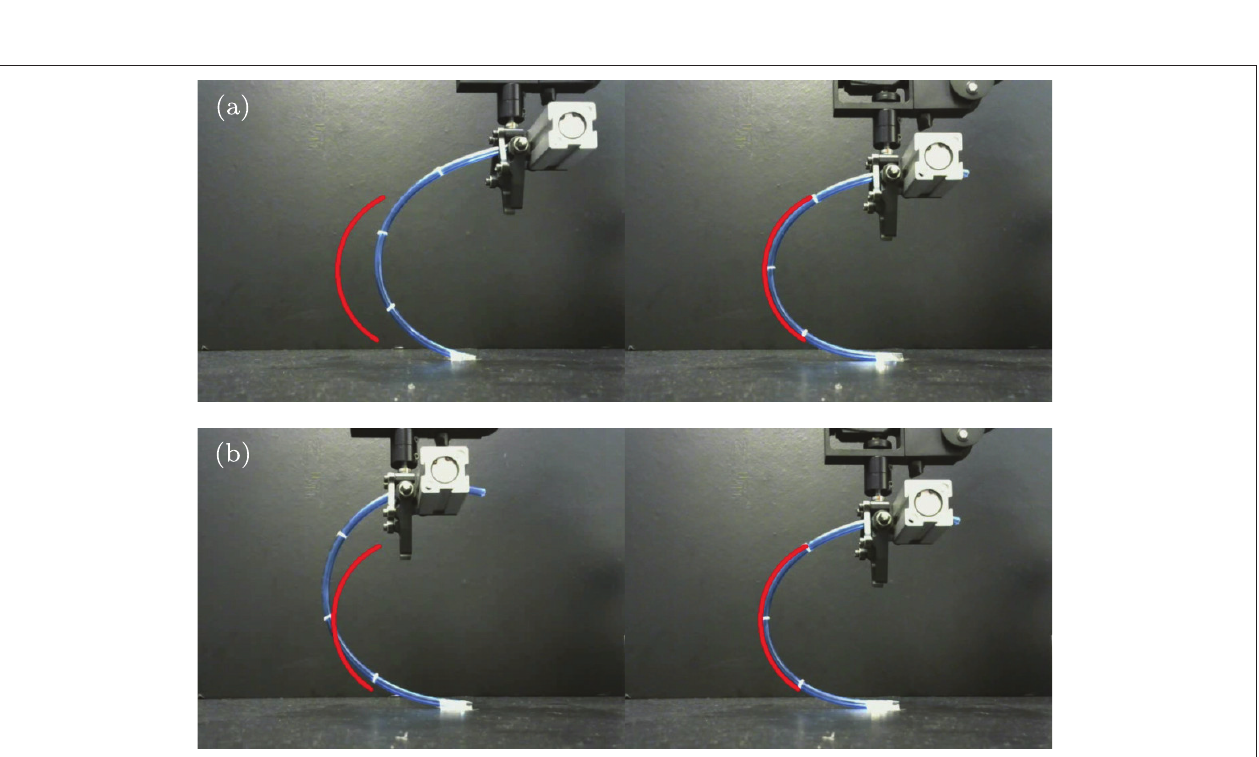
FIGURE 12 | Snapshots of the initial (left) and final (right) configurations for two shape control experiments (a) and (b) , where the red curve represents the target shape.